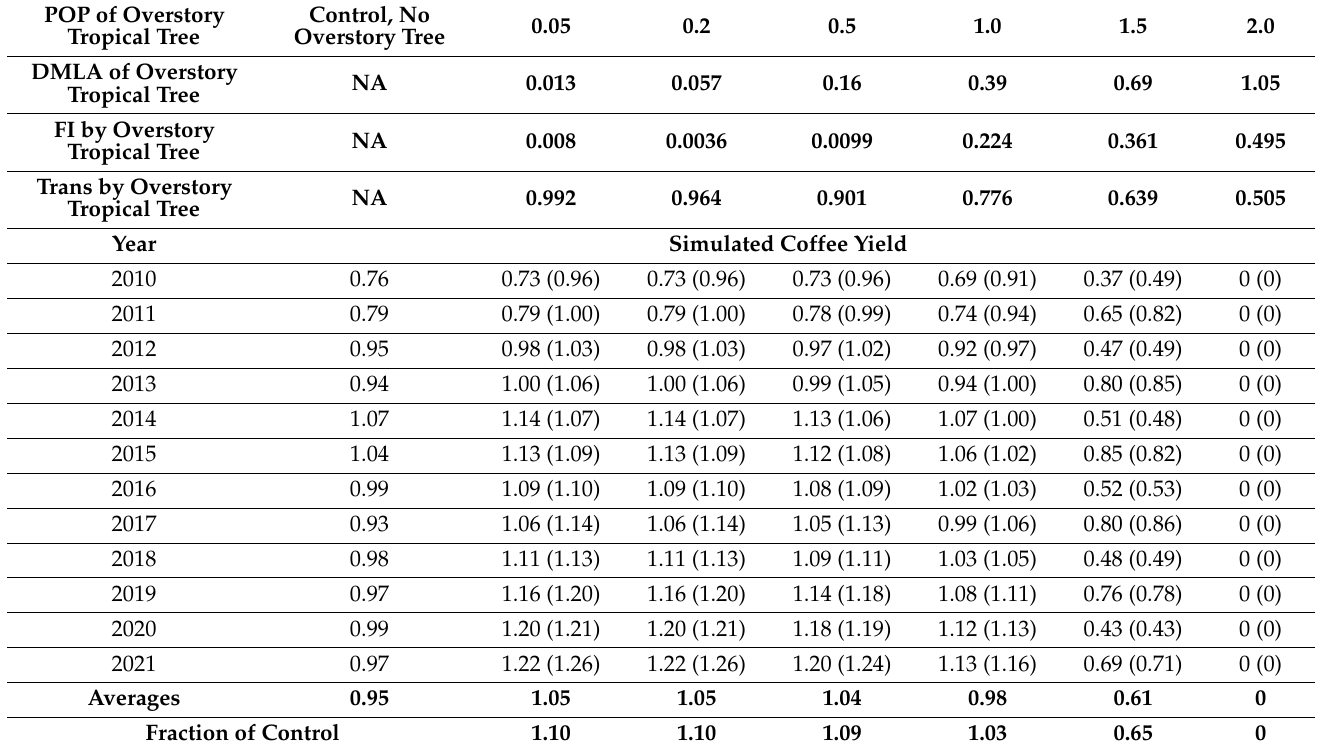
Table 10. Coffee simulation with tropical tree overstory growth planted five years prior to coffee. POP is the plants per 100 m 2 of the tropical trees. DMLA is the potential LAI of the overstory trees. The fraction of light intercepted by the overstory tree (FI) and the fraction transmitted beneath the overstory (Trans) are calculated from the potential LAI (DMLA) and Beer’s Law with the appropriate extinction coefficient. Simulated coffee yield in Mg/ha is indicated and the yield divided by the control is in